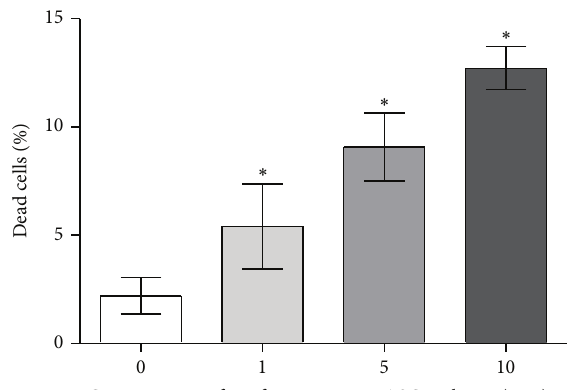
Figure 5: The percentage of dead cells, detecetd using Cellstain Double Staining Kit after 72 h of ASCs culture treated with 1mM, 5 mM,and10mMofmetforminincomparisontothecontrolculture (0mM of metformin).